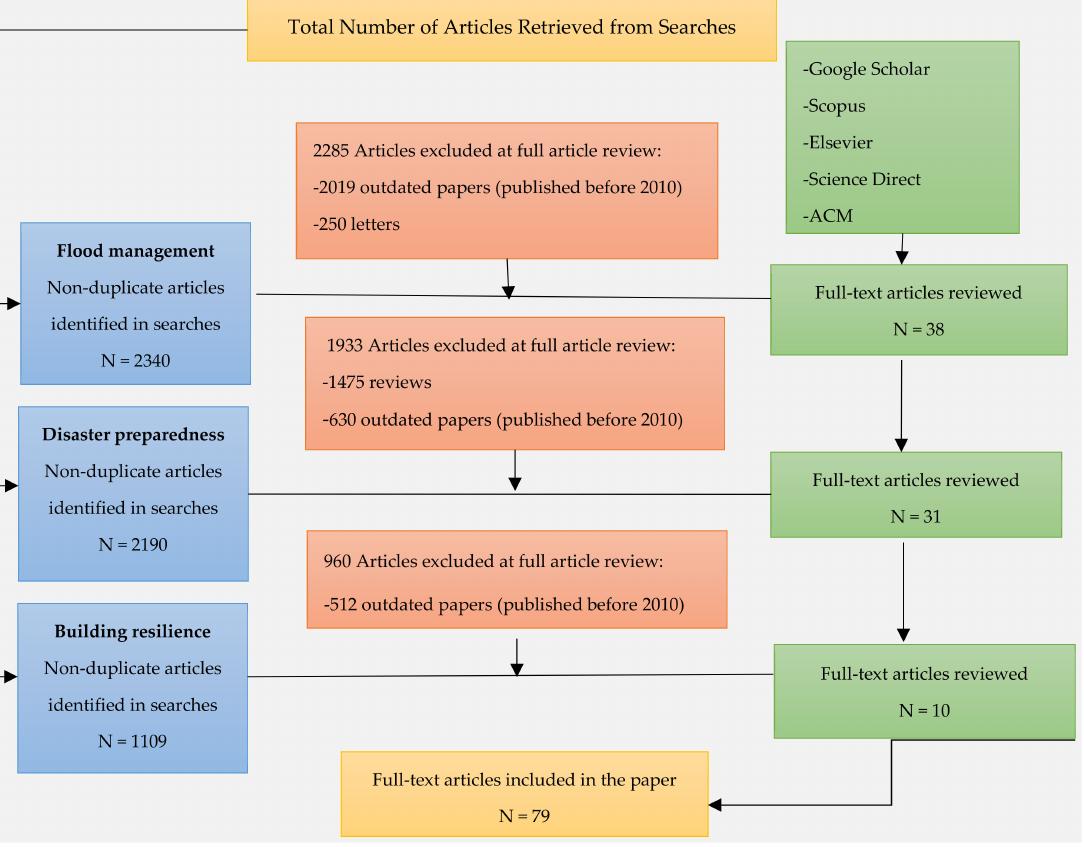
Figure 2. The Detailed Screening